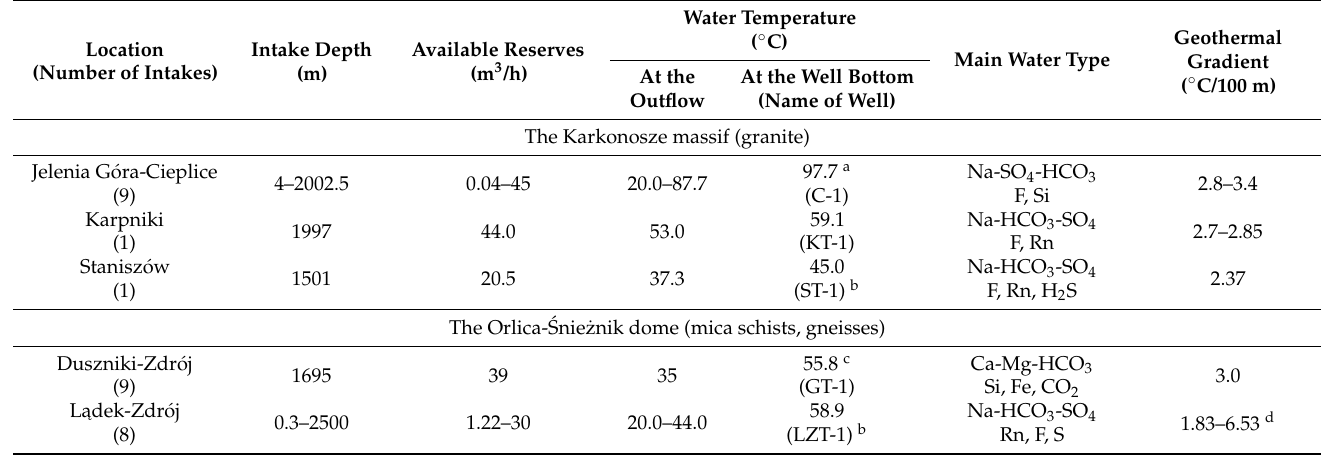
Table 1. Main characteristics of the studied thermal water deposits